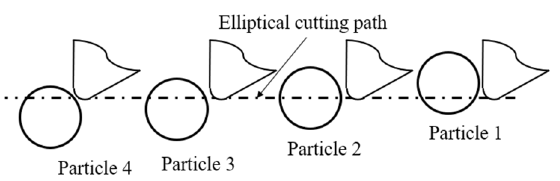
Figure 2. The relative position between particles and the overall cutting path of the tool.